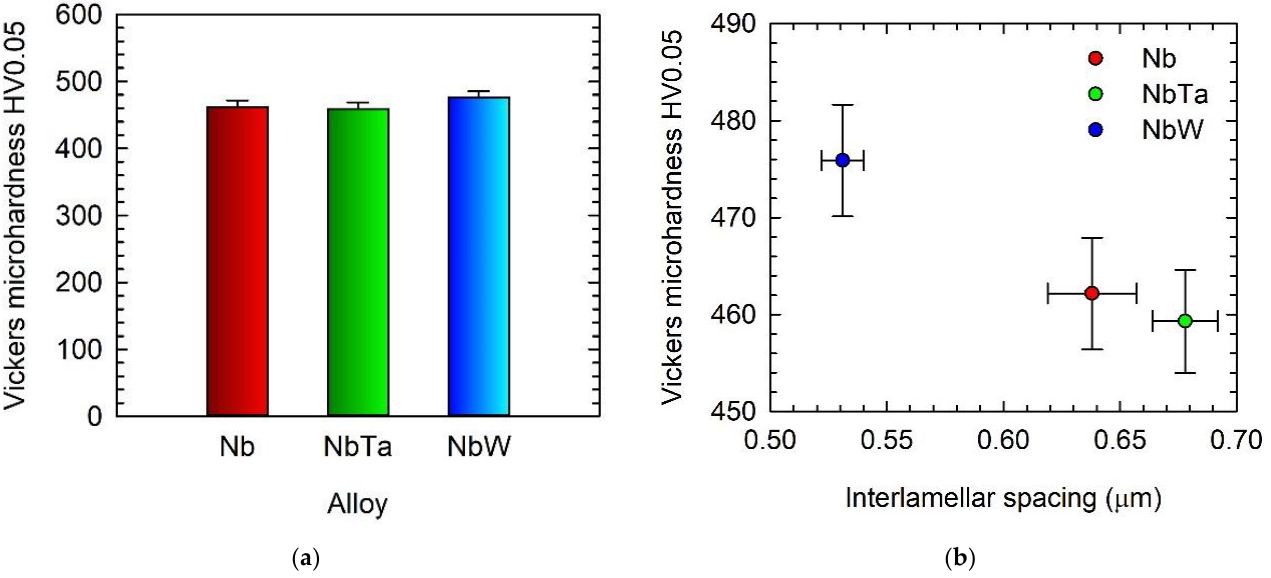
Figure 9. Vickers microhardness of lamellar α 2 + γ regions in the tilt-cast Nb, NbTa, and NbW alloys: ( a ) Vickers microhardness HV0.05, ( b ) dependence of Vickers microhardness HV0.05 on α 2 - α 2 interlamellar spacing. The studied alloys are marked in the figures.